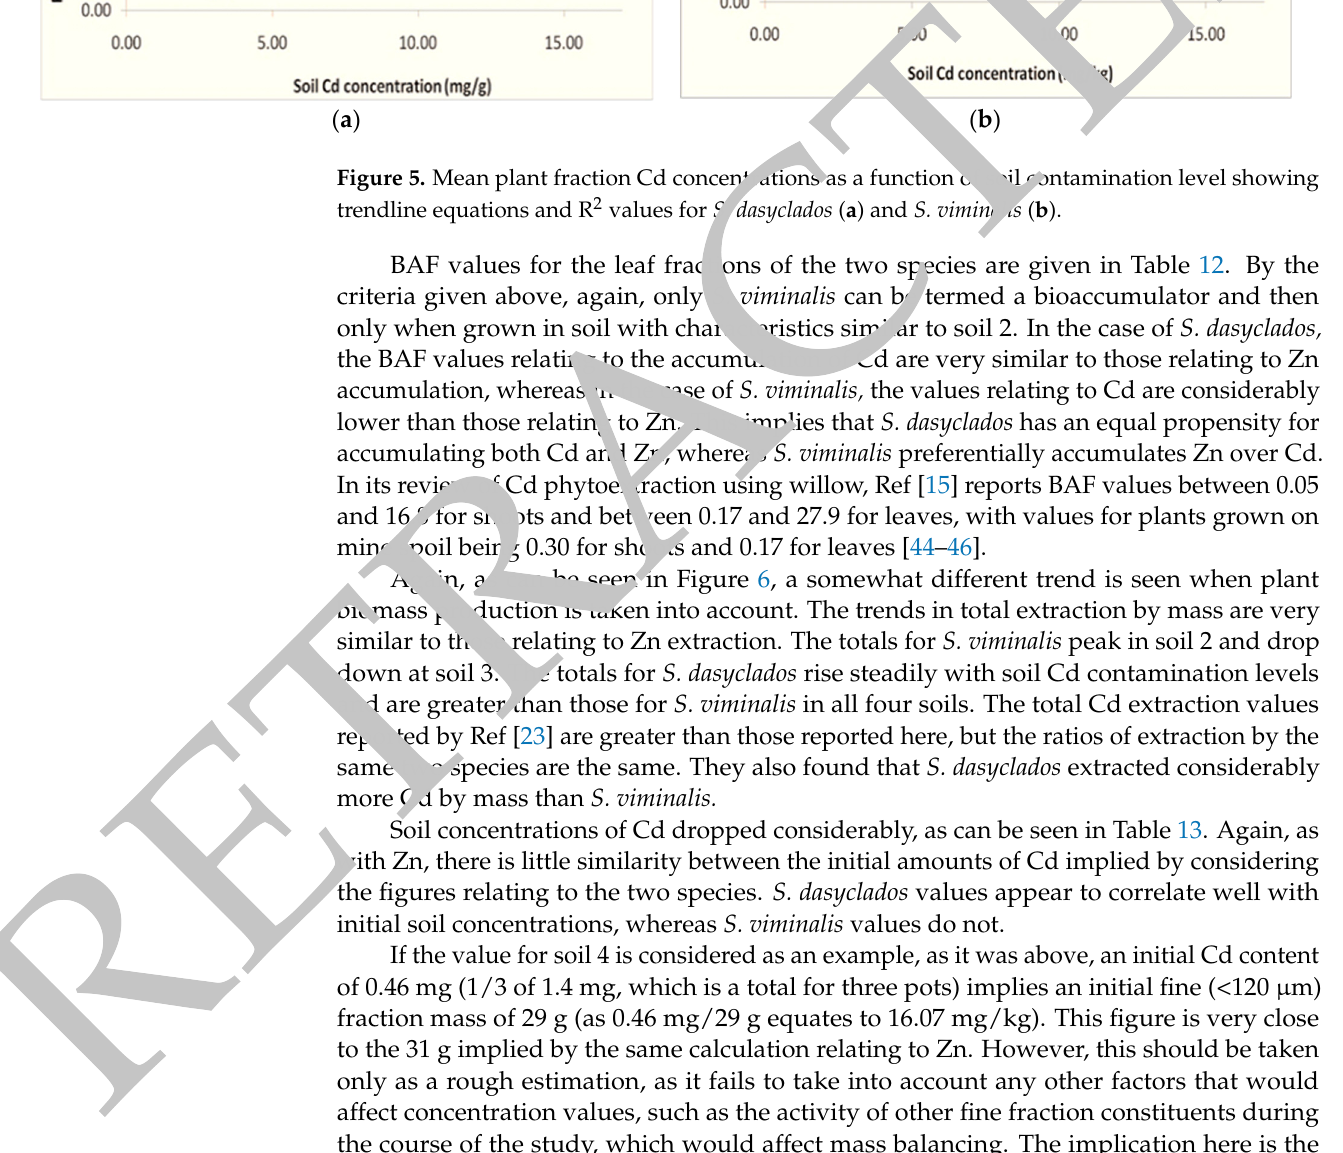
Table 12. BAF values, range and mean (in brackets) for leaf fraction plant samples with regard to Cd.